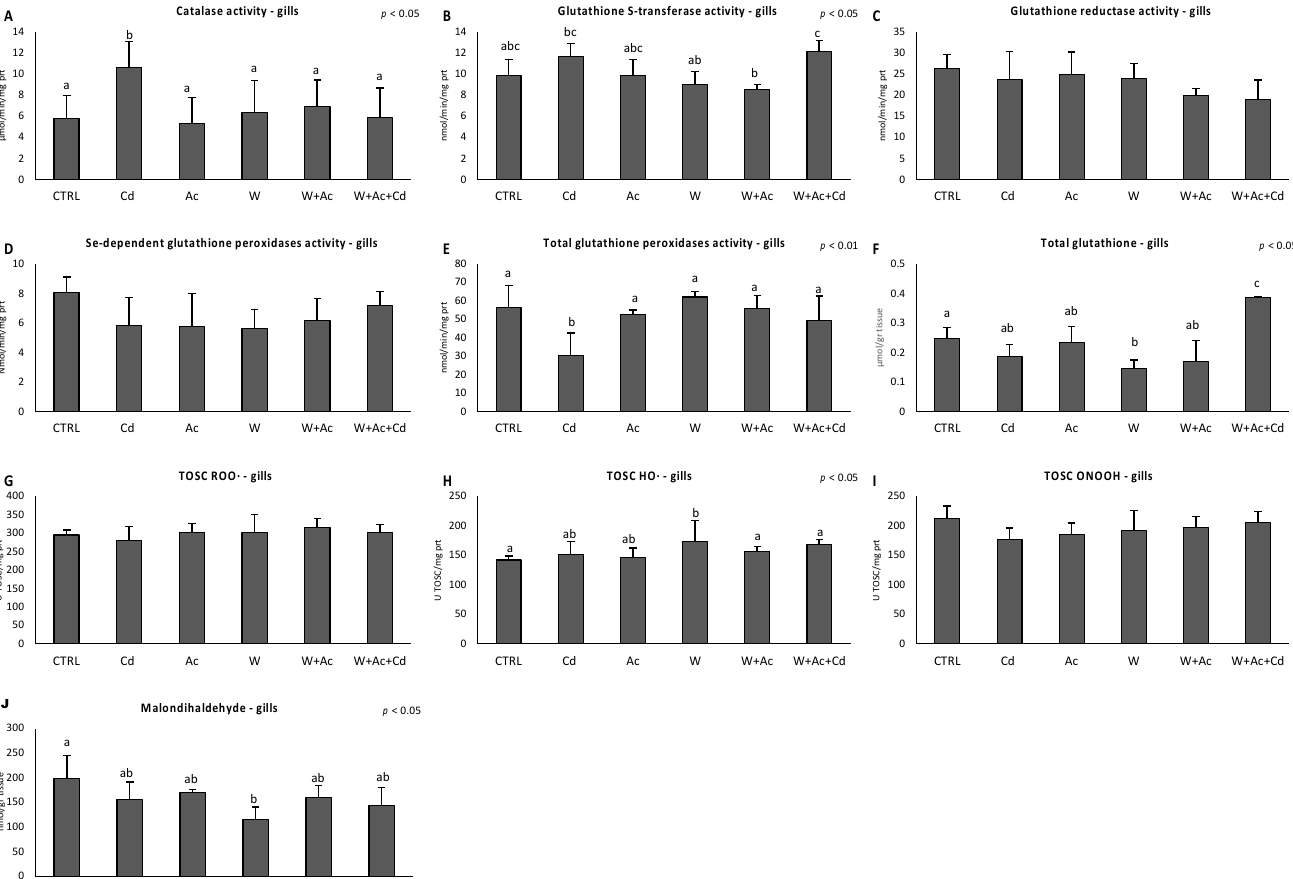
Figure 4. Activities of individual antioxidant enzymes ( A – E ) and total glutathione concentration ( F ), Total Ox-yradical Scavenging Capacity (TOSC) toward peroxyl and hydroxyl radicals and peroxynitrite ( G , TOSC ROO • , H TOSC HO • and I , TOSC ONOOH, respectively), and malondialdehyde content ( J ) in gills of T. bernacchii exposed to dif-ferent exper- imental conditions. Different letters highlight significant differences between groups of means. Data are ex-pressed as mean ± standard deviations, n =